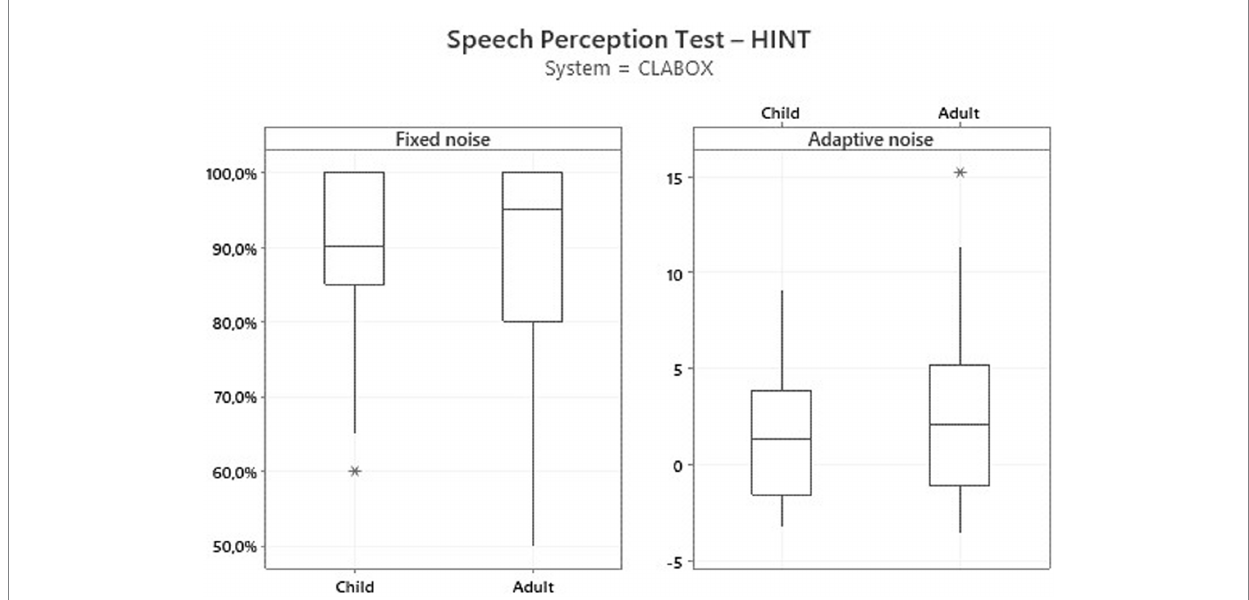
FIGURE 1 HINT with fixed noise (S/N + 10 dB) and adaptive noise at 55 dB in the SB. The box plot represents the 25th and 75th percentiles (box boundaries) and the medians (horizontal line). Outliers are indicated with asterisks.